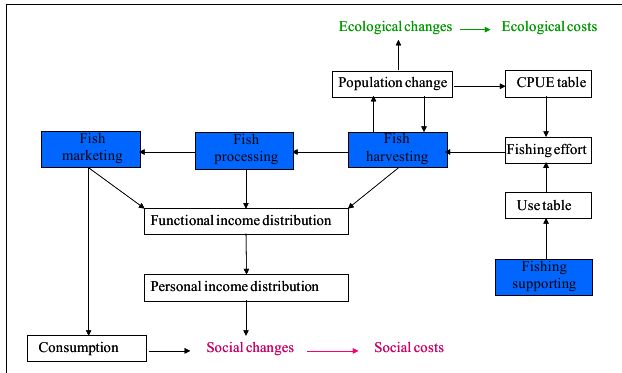
FIGURE 1 | A fisheryeconomic model with full production chain and linkages to social and ecological systems.